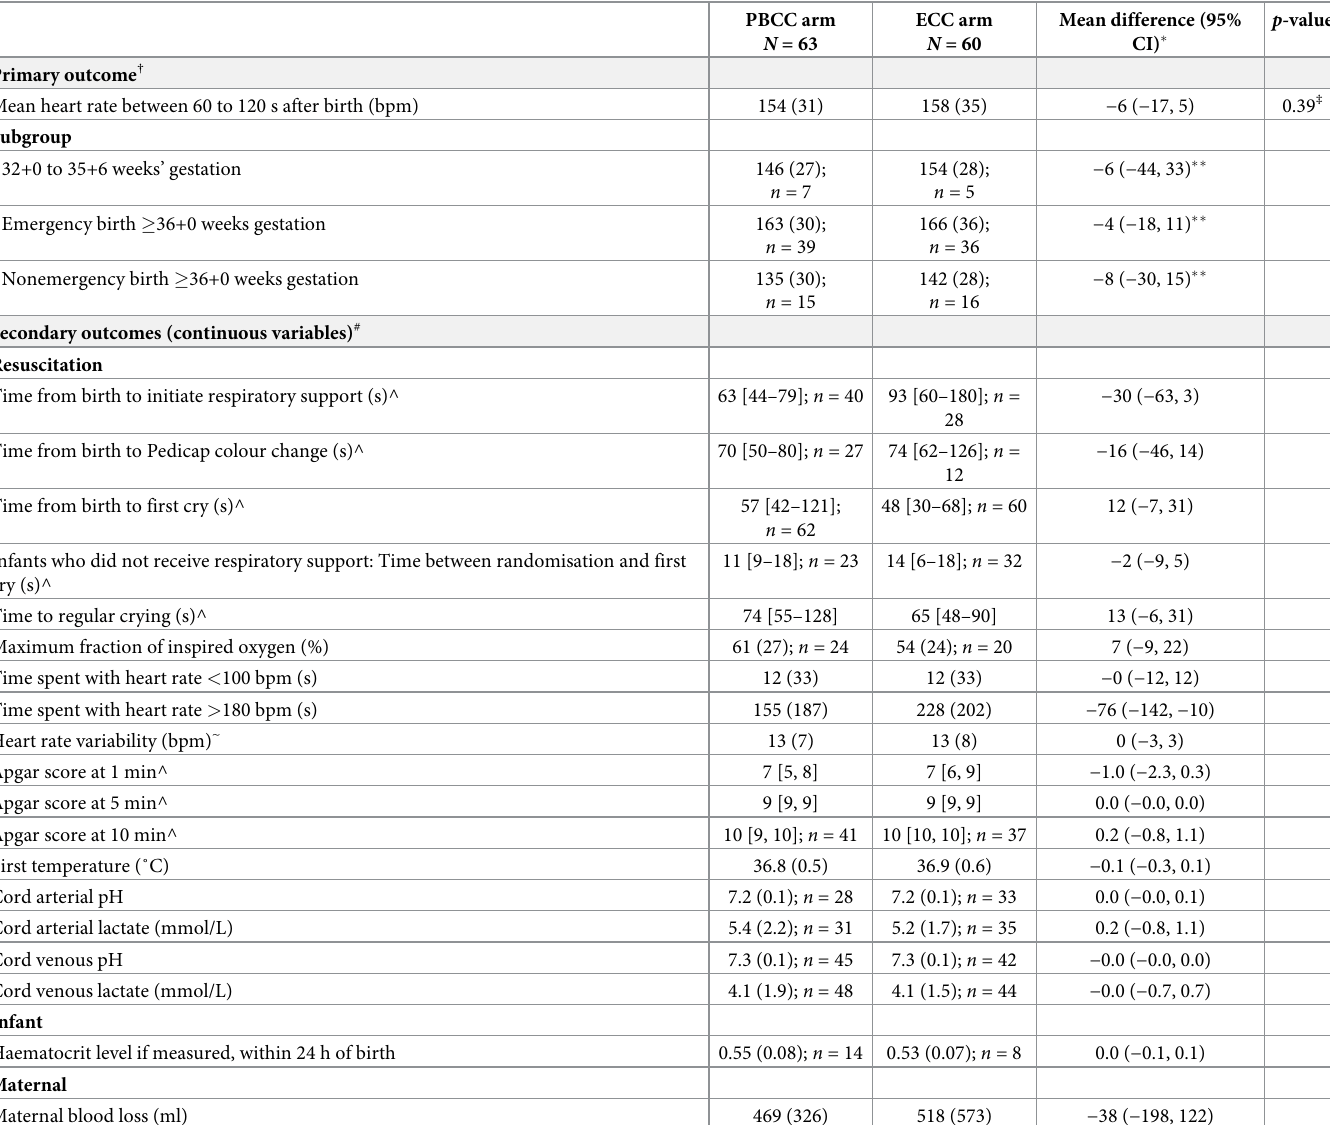
Table 2. Primary outcome and secondary outcomes for continuous